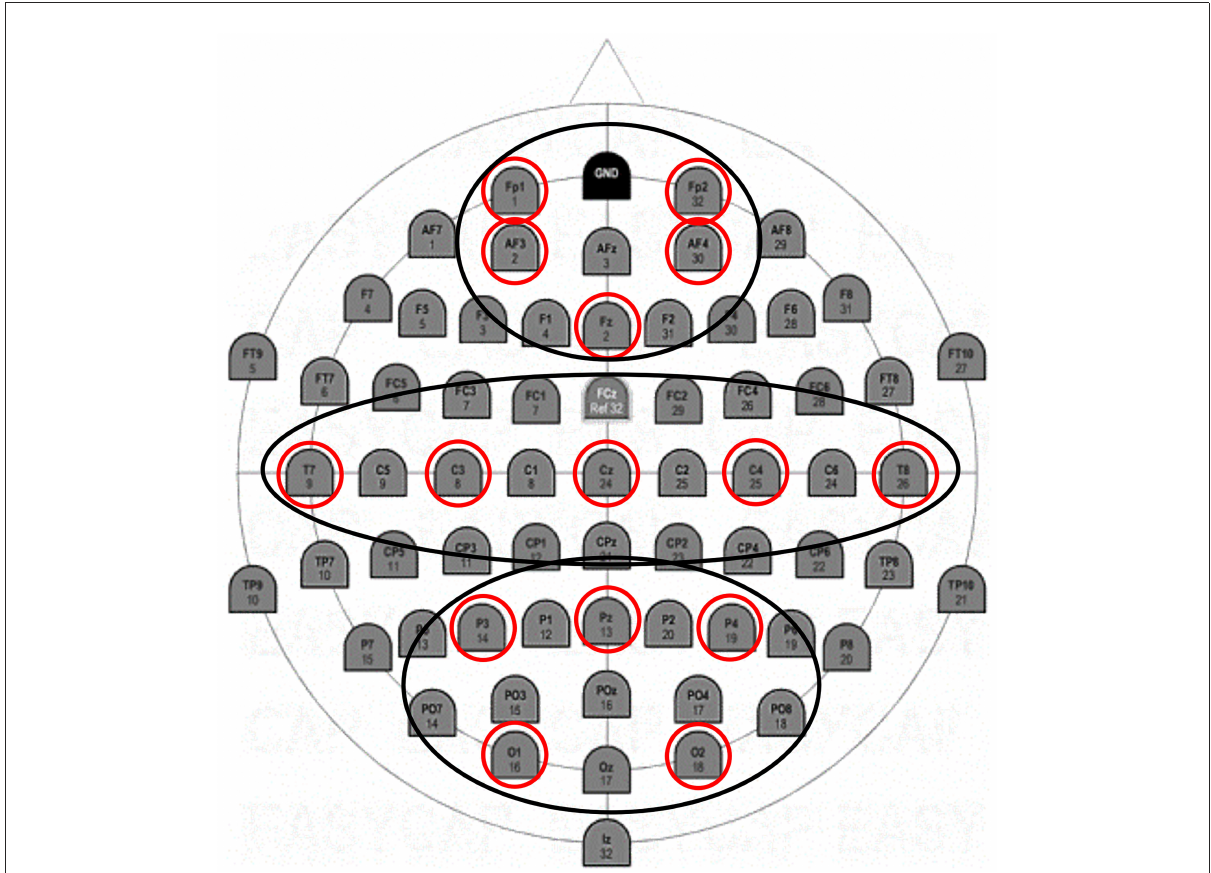
FIGURE2 EEG montage. Positioning of 15 electrodes according to the 10–20 international